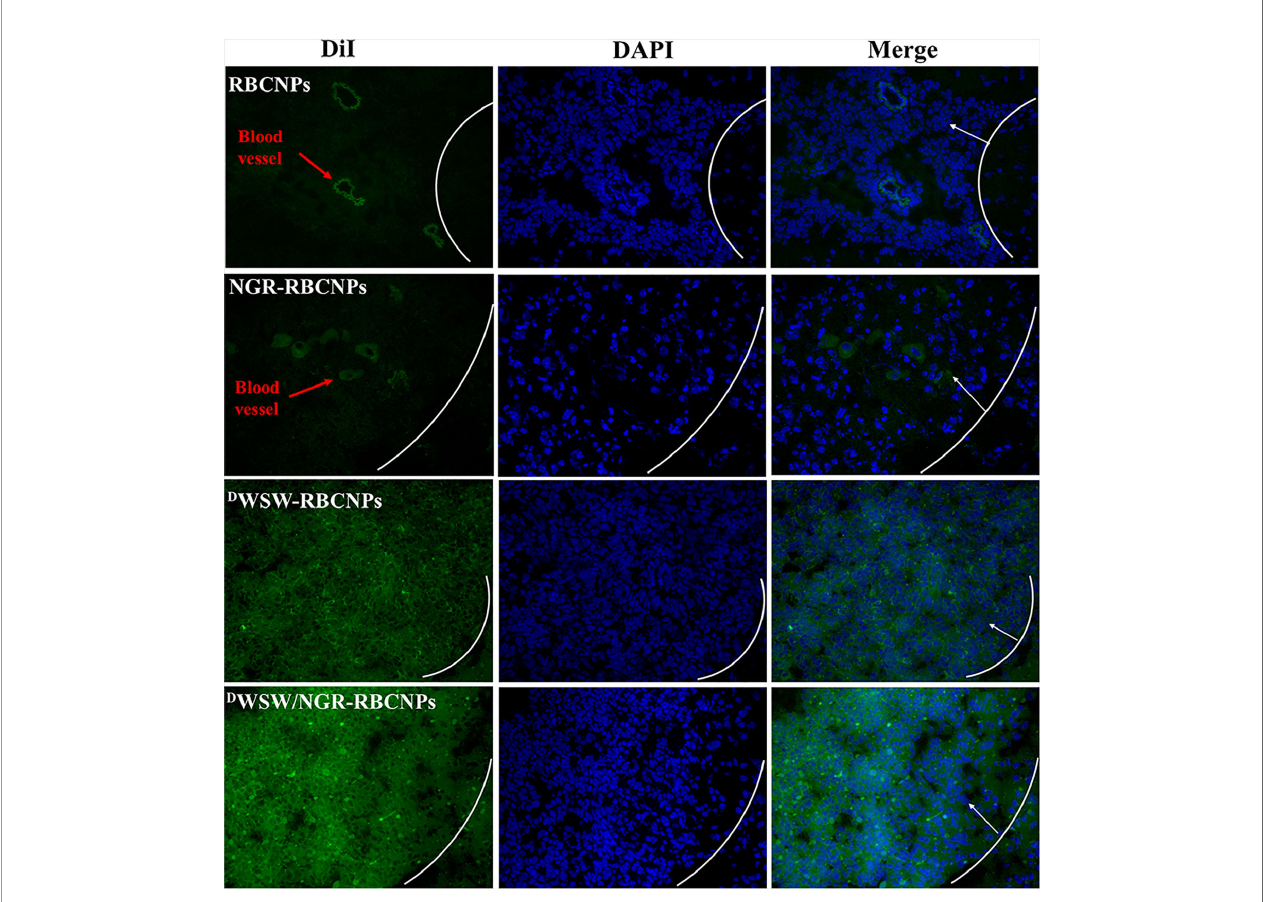
FIGURE 6 | Targeted distribution of nanoparticles in brain tissue. Distribution of DiI-encapsulated nanoparticles in the brain of mice bearing intracranial C6 gliomas, as determined by confocal laser microscopy. The white line shows the margin of the intracranial glioma while the arrows indicate glioma cells. The green color represents DiI- encapsulated nanoparticles, while nuclei are shown in blue (DAPI). 784 DWSW/NGR-RBCNPs showed the strongest targeting ability. Scale bar, 20 m